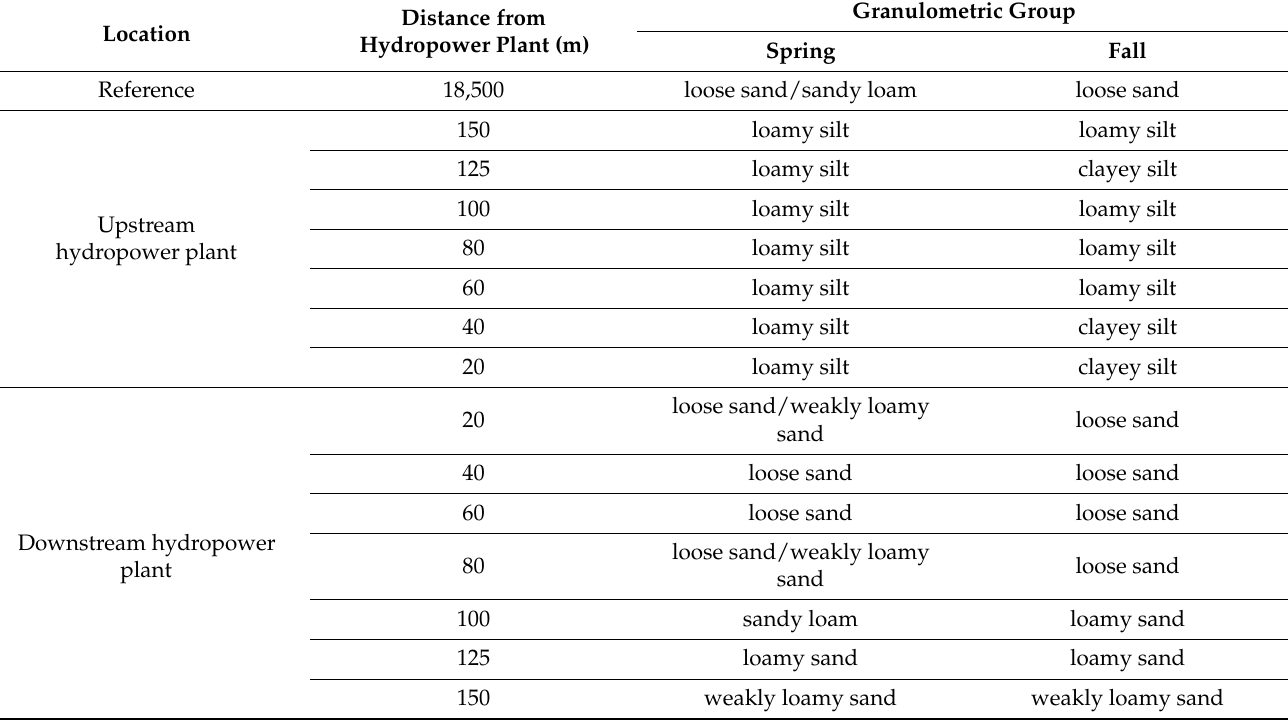
Table 4. Classification of the granulometric composition of sediments near the hydroelectric power plant on the ´Sl˛eza River. Location